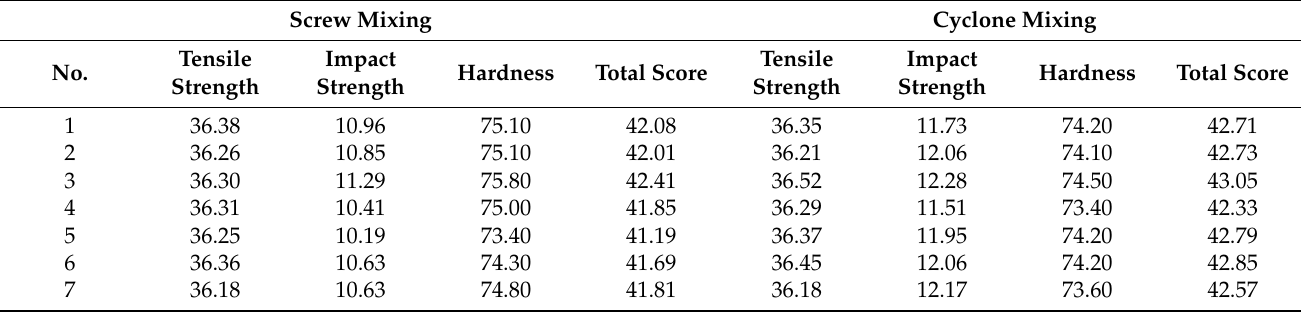
Table 11. Integrated quality data